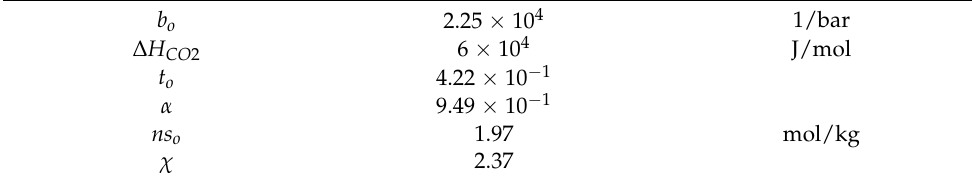
Table 8. Toth parameters for APDES-NFC-FD sorbent